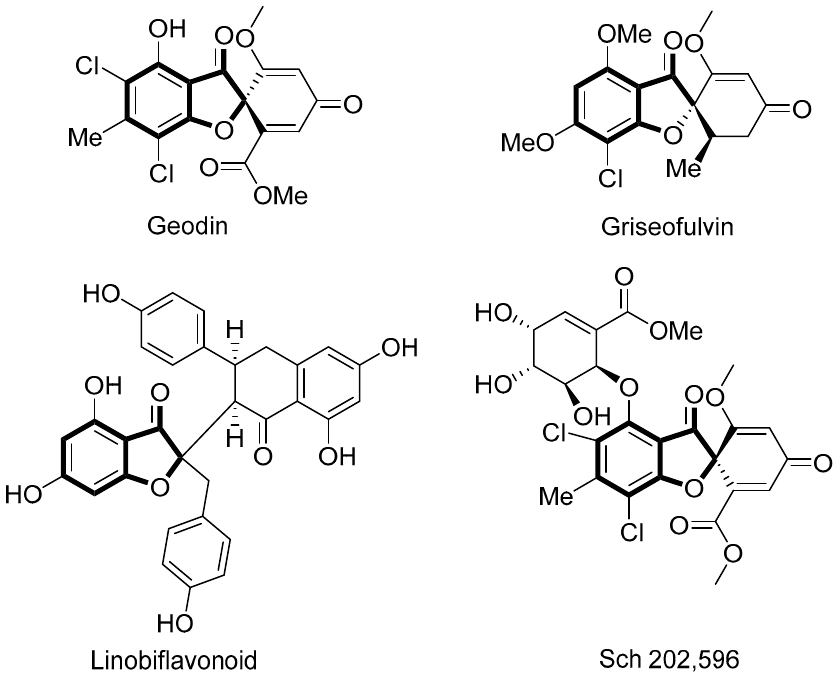
Figure 1. Selected benzofuran-3(2 H )-one-derived natural products.